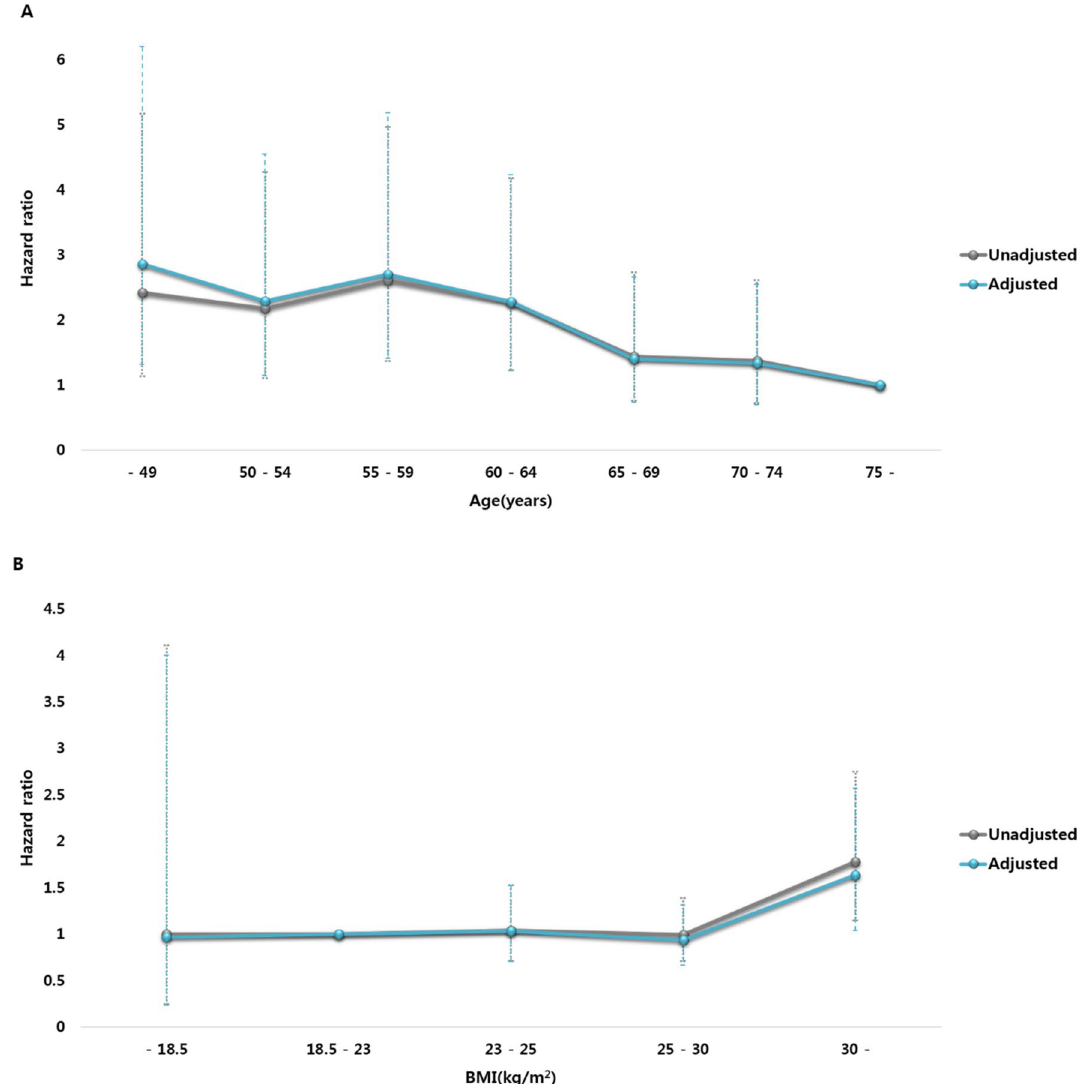
Figure 3. HR (95% CI) of TTA failure according to age ( A ) and BMI ( B )